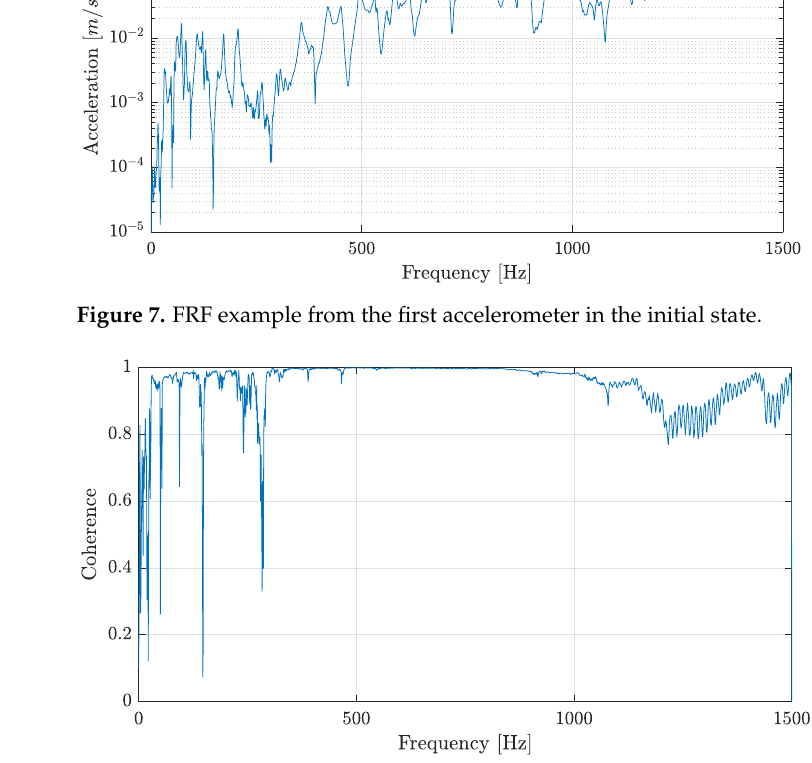
Figure 8. Coherence example from the first accelerometer in the initial state.